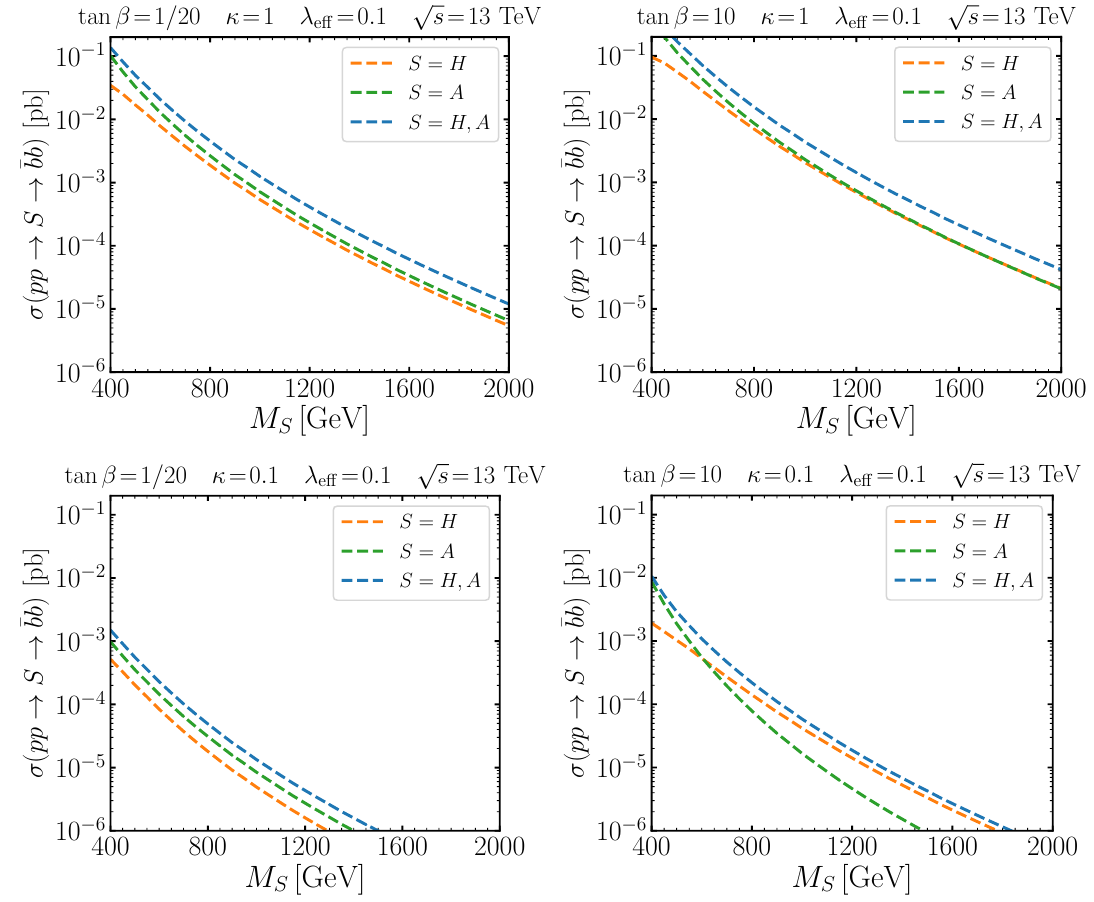
¯ bb . The dashed orange (green) line